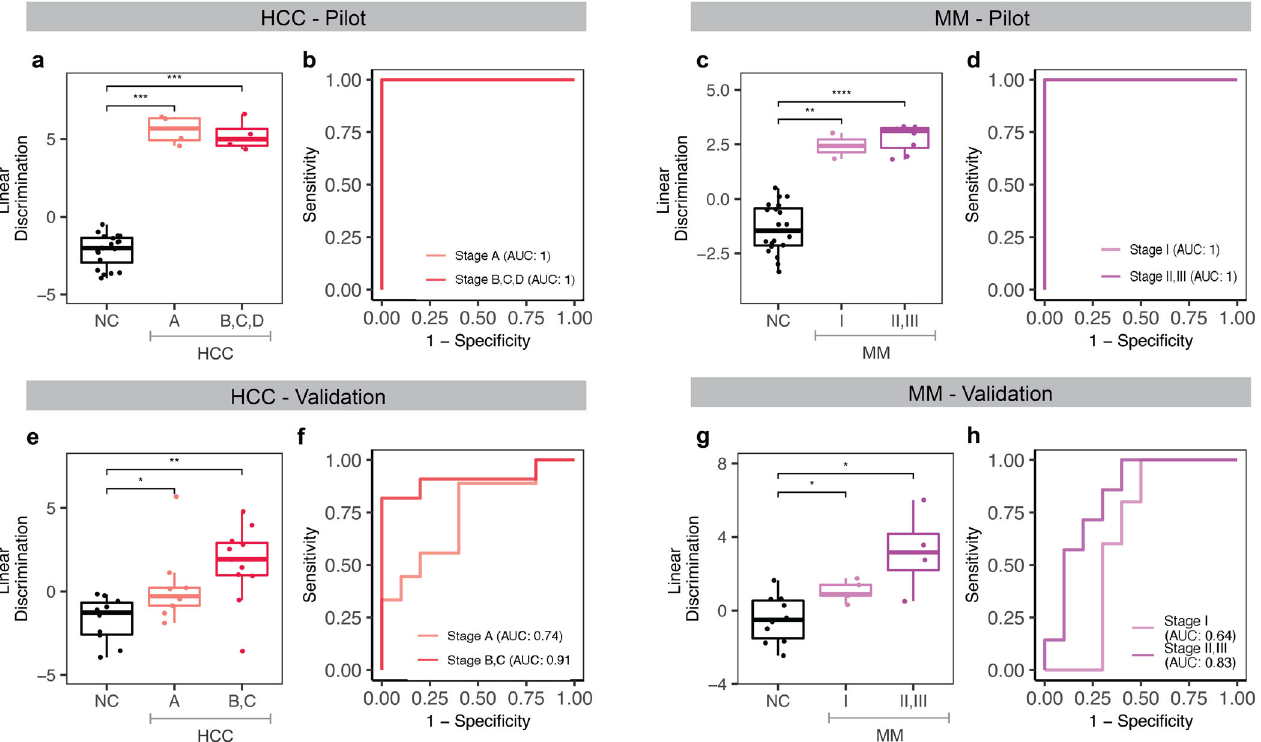
Fig. 6 cfRNA biomarkers show clinical stage-dependent discrimination in pilot and validation sample sets. a – d Linear discriminant analysis using the top ten LVQ genes and model trained in the pilot cohort shows signi fi cant discrimination and classi fi cation by clinical stage in both HCC ( a , b ) and MM ( c , d ). e – h When classifying the independent validation cohort with these same models, we see stage-dependent classi fi cation for both HCC ( e , f ) and MM ( g , h ). P value for each pair in ( a , c , e , g ) was calculated by the Wilcoxon rank-sum test, and elements of the boxplots include the median value across all patients in that group shown by the center-line and the hinges which represent the lower (Q1) and upper (Q3) quartile, with whiskers extending to the minimum and maximum of the resulting distribution.